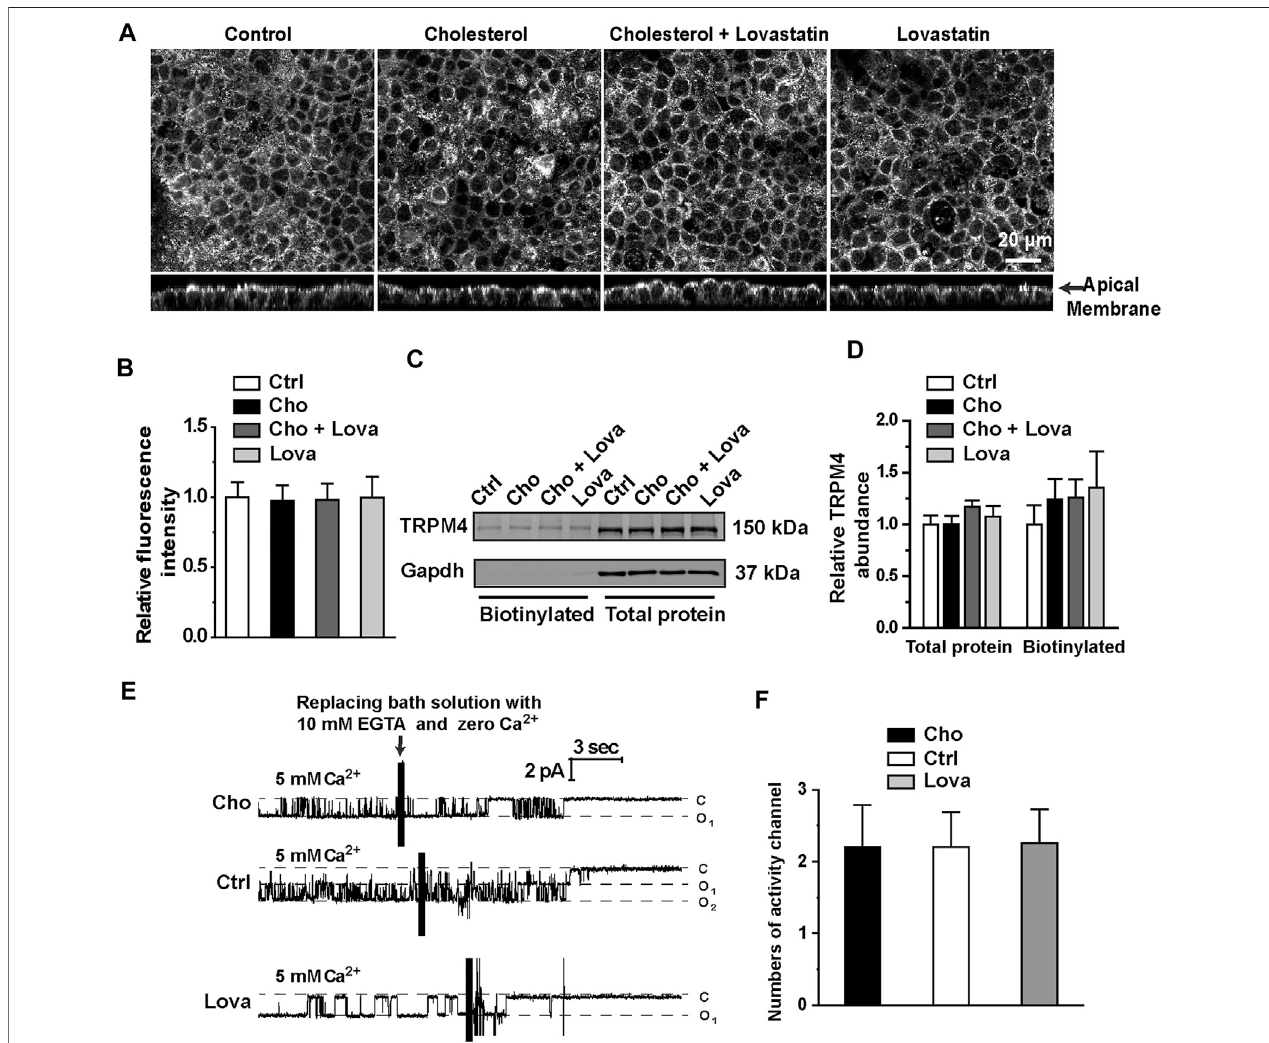
FIGURE 7 | Treatment with cholesterol or lovastatin does not alter expression levels of TRPM4 in mpkCCDc14 Cells. (A) Representative confocal microscopy images of mpkCCDc14 cells stained with TRPM4 antibody under each indicated conditions. (B) Summary plots of fl uorescence intensity of TRPM4. Data are from 24 cells in four sets of separate experiments. (C) Representative Western blotsfrom cell-surface biotinylated and the total proteins ofTRPM4 protein. (D) Summary plotsof relative expression of TRPM4. Cells were either under control conditions or treated with 30 μ g/ml cholesterol alone, 30 μ g/ml cholesterol plus 5 μ M lovastatin, or 5 μ M lovastatin alone for 48 hrs, respectively. n (cid:2) 5. (E) Representative single channel recording from inside-out patches exposed the patch membrane to the bath containing5